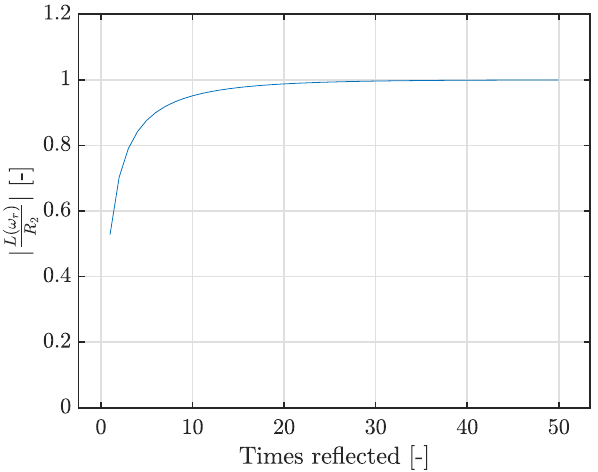
Figure 13. The magnitude of the lubrication layer spectrum as a function of the number of times the ultrasonic pulse is reflected within the lubrication